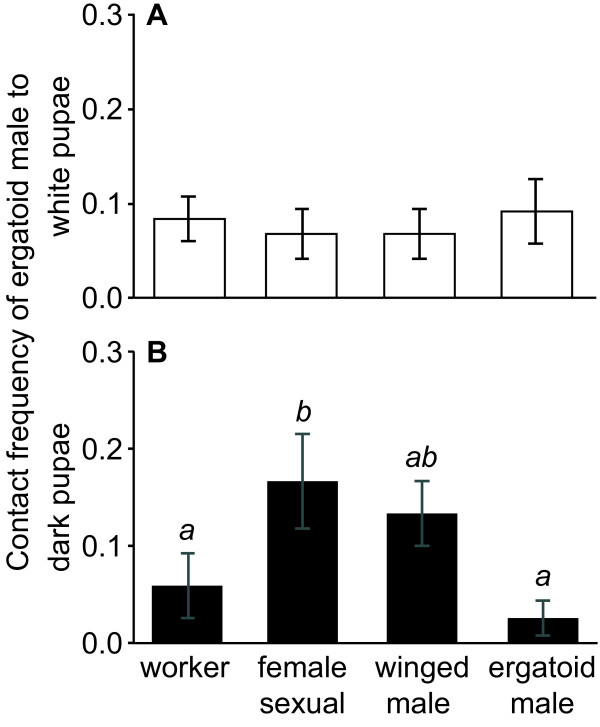
Contact of adult ergatoid males towards pupae of all colony members in the ant Cardiocondyla obscurior. A) Ergatoid males did not preferentially contact any type of pupae when all pupae where white and thus several days prior to emergence. B) Dark, ready-to-eclose pupae of workers and ergatoid males were contacted less frequently than female sexual pupae, as well as winged male pupae. Bars represent mean values and whiskers the standard error of the mean. Small italic letters indicate significance groups for the dark pupae that showed significant overall differences.